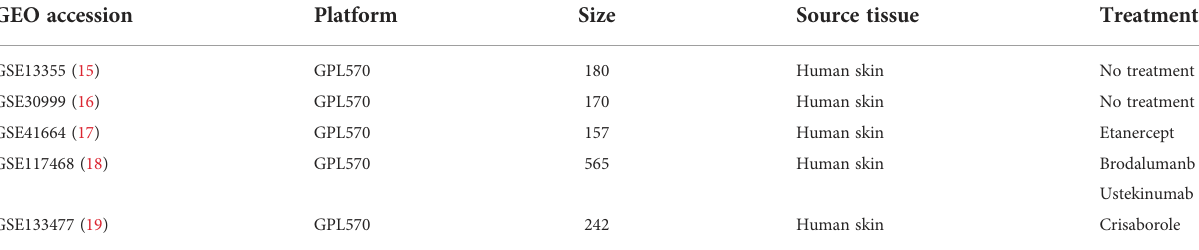
TABLE 1 Information of GEO